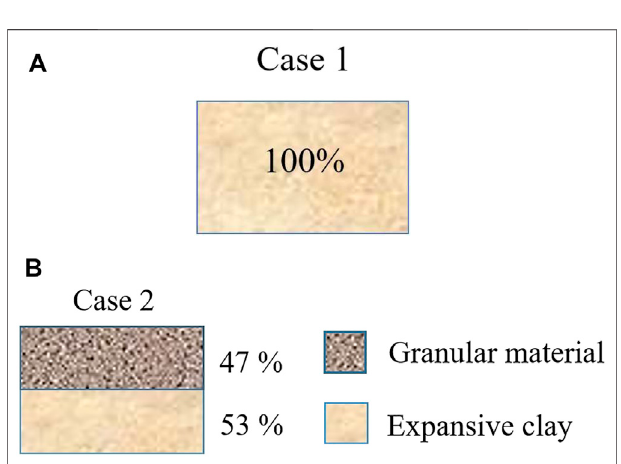
TABLE 4 | S1 expansive clay